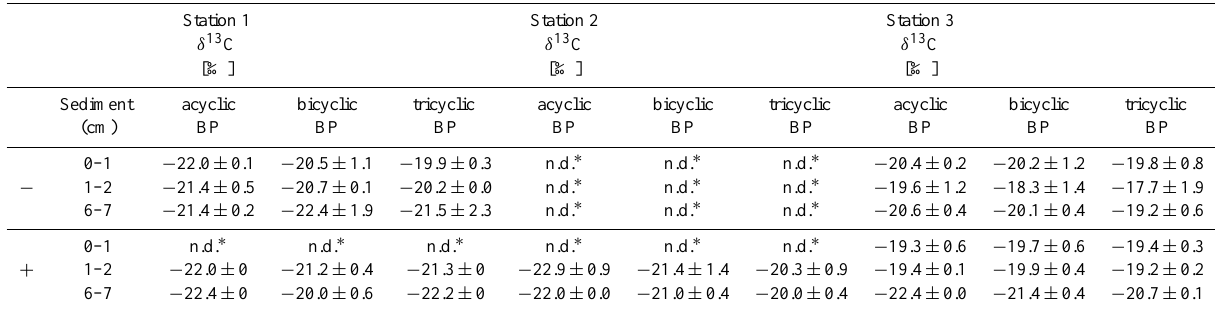
Table 3. Background (BG) values of δ 13 C of the biphytanes (BP) measured in the sediment (i.e. δ 13 C of the biphytanes that were incubated just with water, but under the same conditions). These values were used for determination of the 1δ 13 C: BG values were subtracted from the δ 13 C of the corresponding value measured from the cores incubated with label (Fig. 6). Numbers indicate the depth interval the sample was coming from, + : nitrification inhibitor nitrapyrine added for incubation, – : no inhibitor added. Values at station 2 could not be determined due to low concentrations.